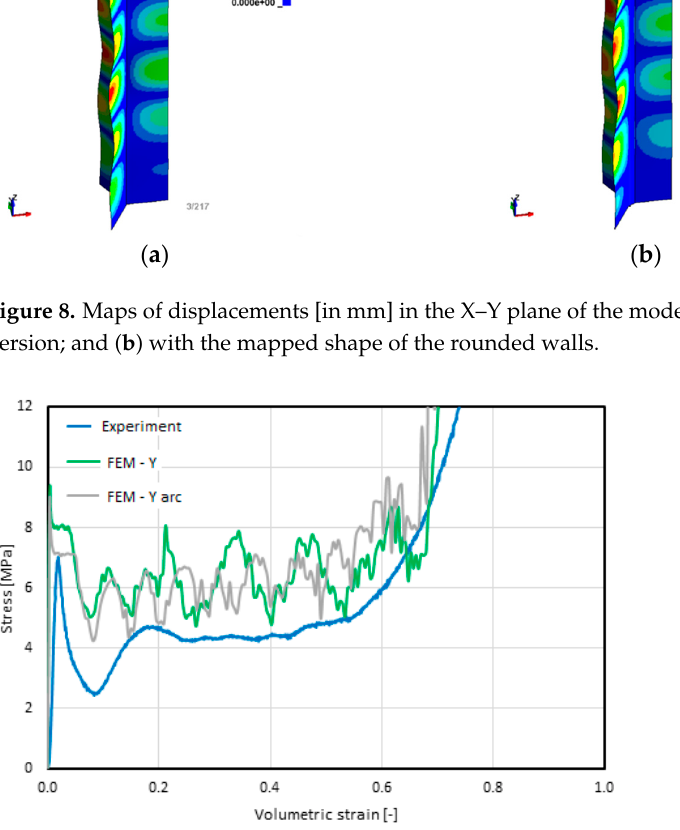
Figure 9. Comparison of the stress–volumetric strain characteristics of material 1/8-5052-0.0015 obtained for the following versions of the models: straight/idealized (FEM–Y, green line); with the mapped shape of the rounded walls (FEM–Y arc, gray line); and experimentally obtained characteristics, blue line [21].